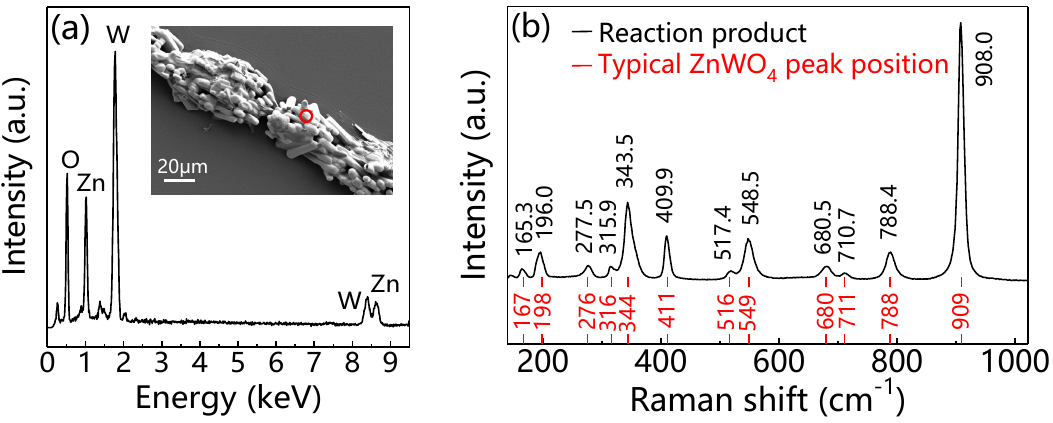
Figure 6. ( a ) EDS and ( b ) Raman spectra of ZnO crystal whisker after WS 2 growth. Insert in ( a ) is the SEM image with a red circle where the EDS spectrum is taken from. The data in black and red color in ( b ) correspond to our experiment and reference [31,32], respectively.